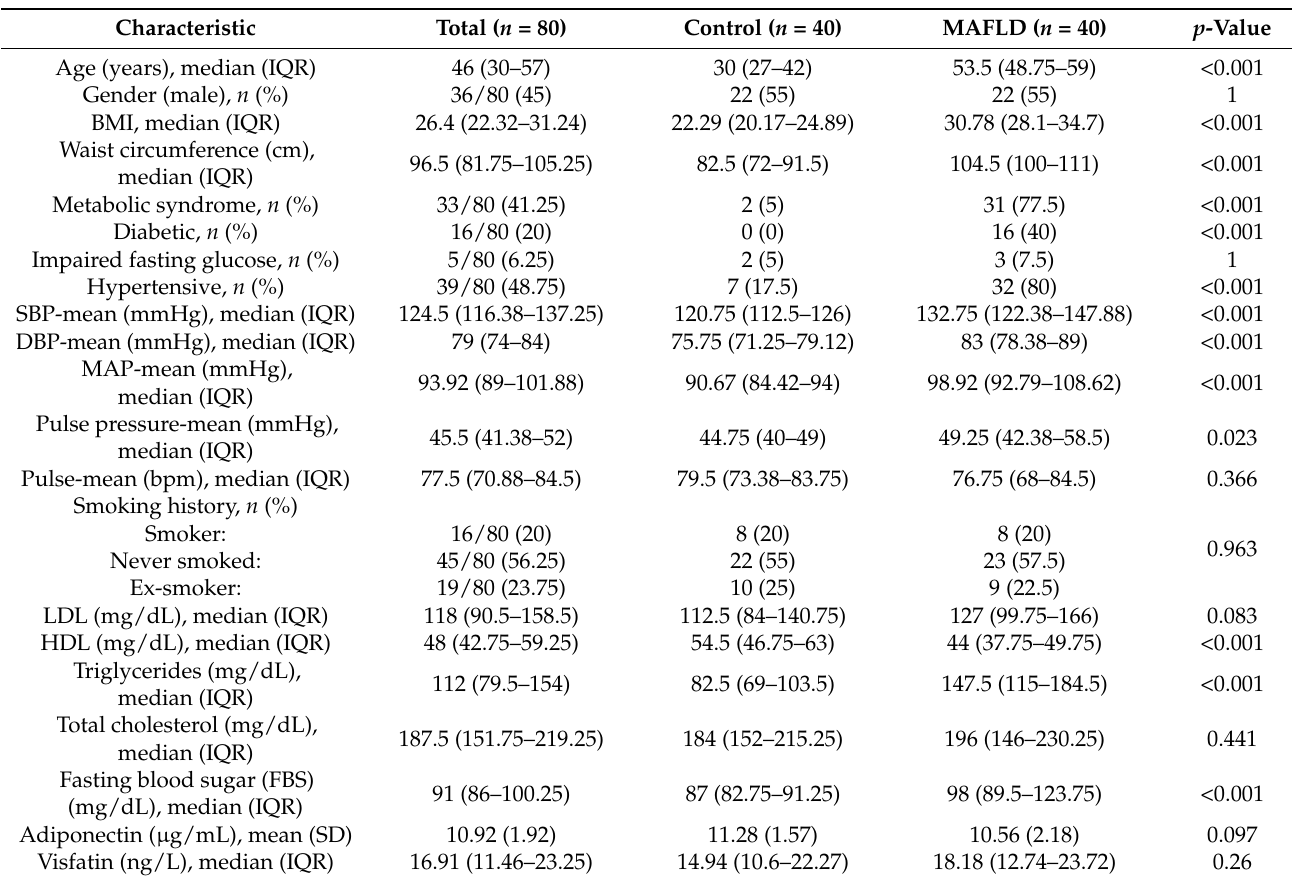
Table 1. General characteristics of included